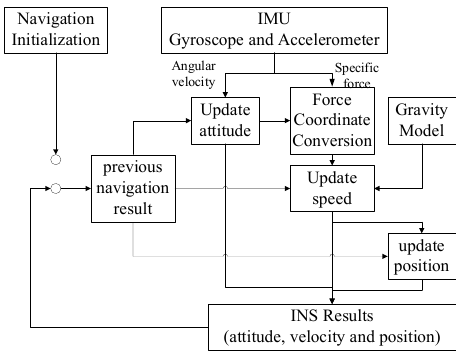
Figure 1 . INS mechanization